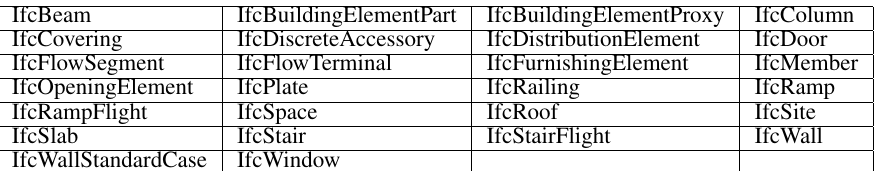
Table 1. Object ID, Name, Scale and Offset in Dataset.